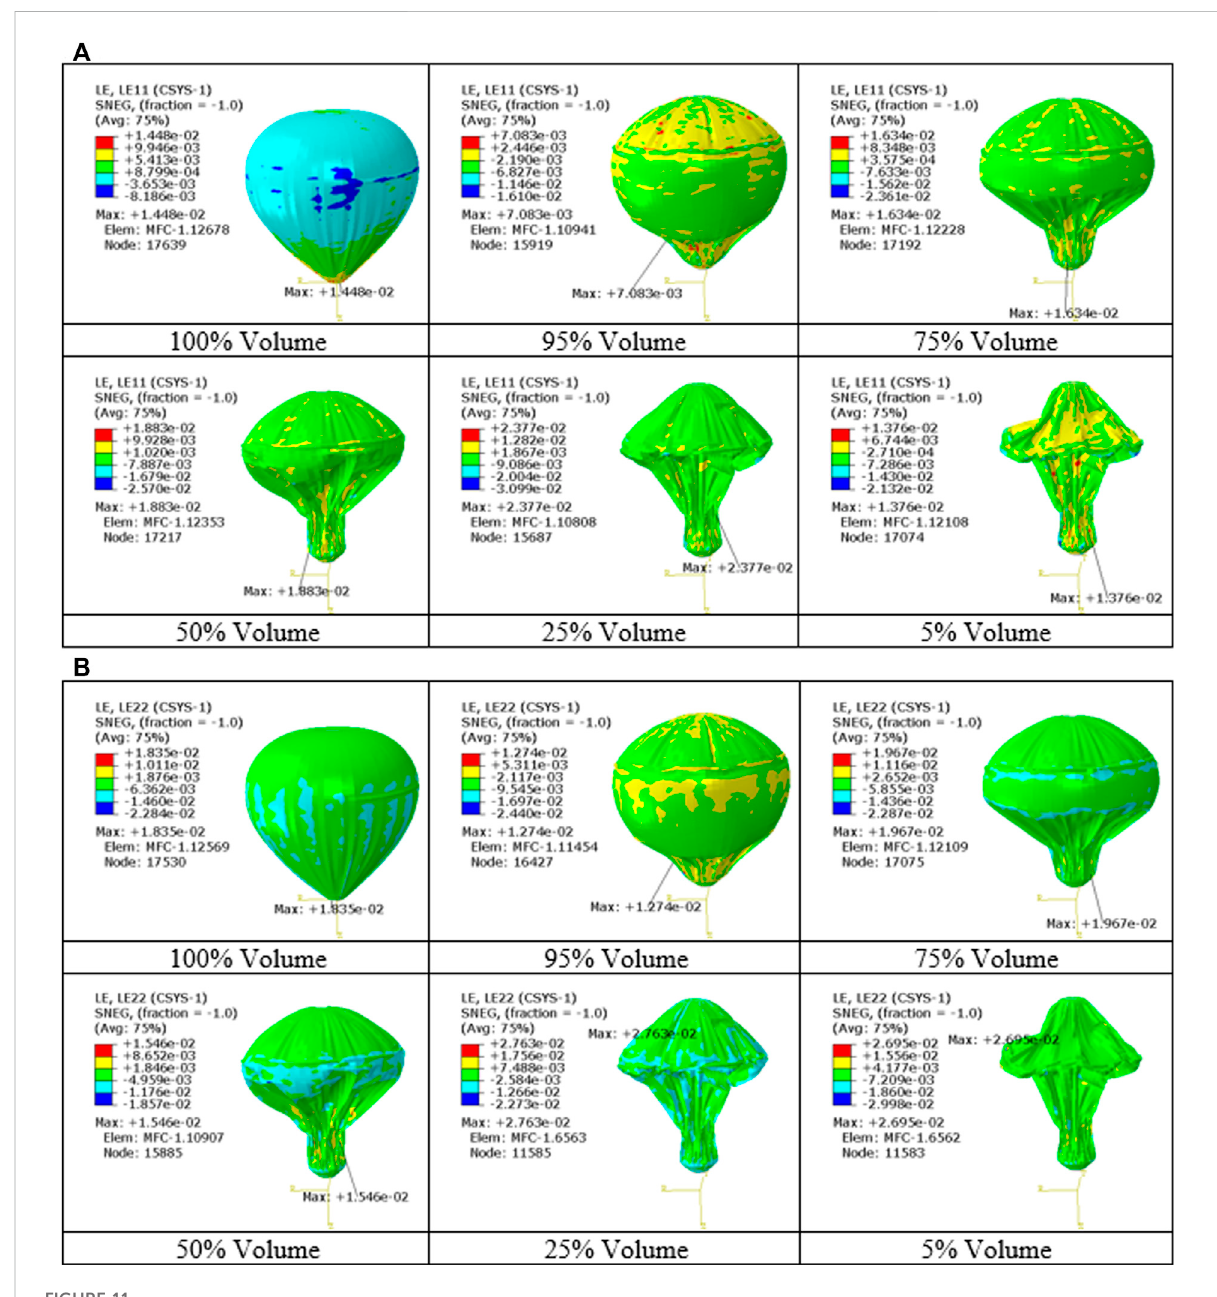
FIGURE 11 Membrane strain at different volumes: (A) longitudinal direction; (B) latitudinal direction.